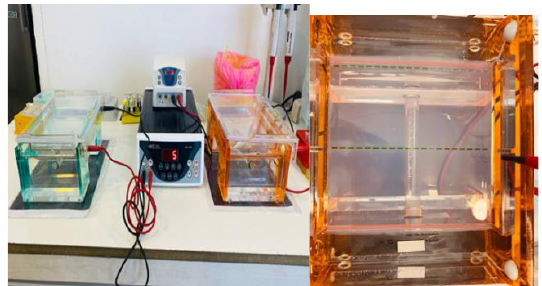
Figure 2: The PCR tubes in 96 well thermal cycler